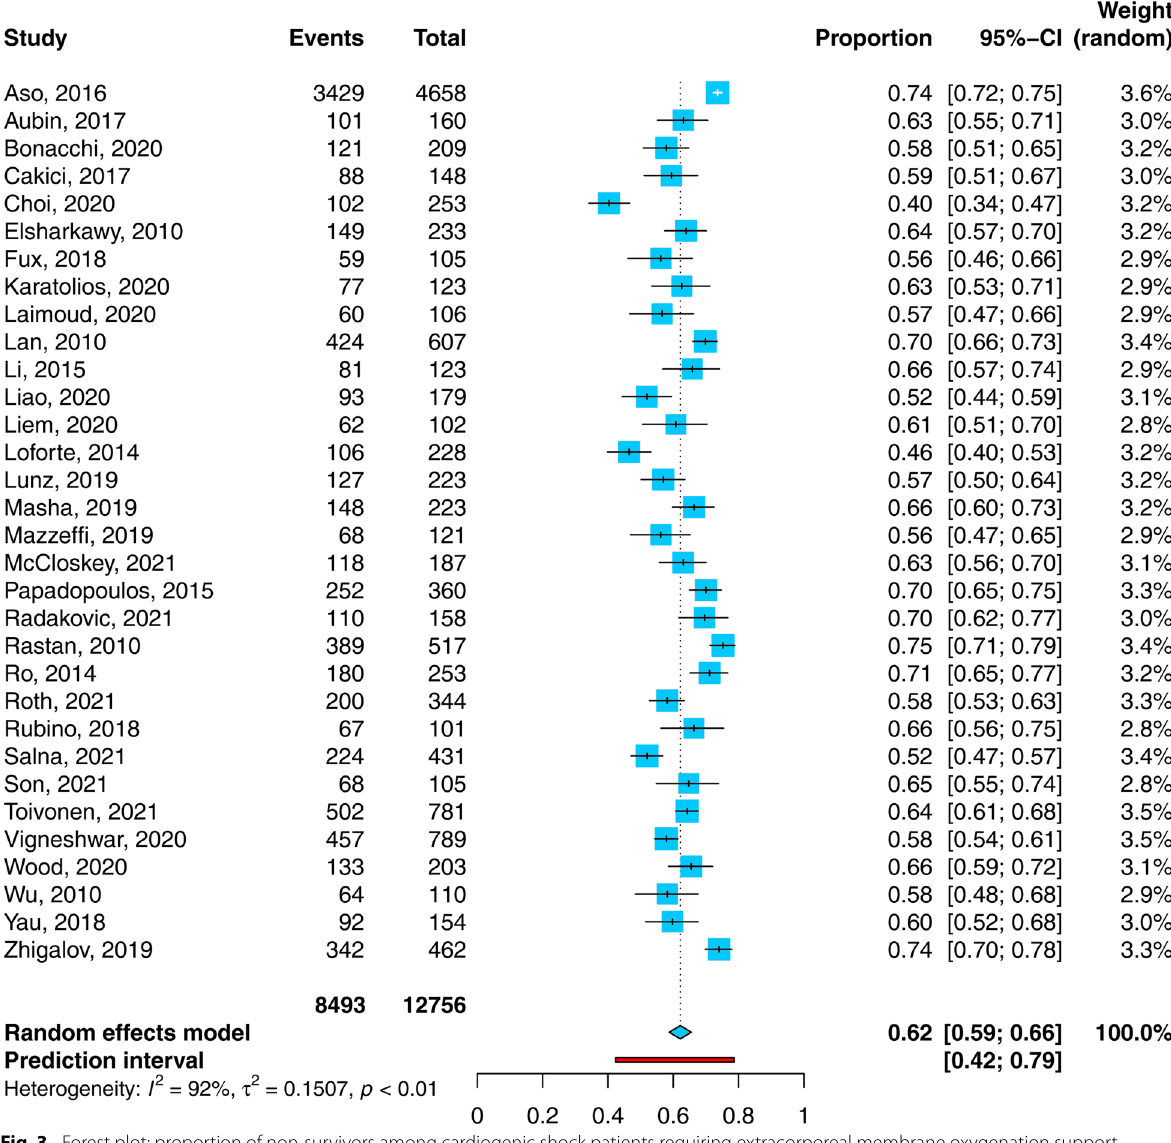
Fig. 3 Forest plot: proportion of non-survivors among cardiogenic shock patients requiring extracorporeal membrane oxygenation